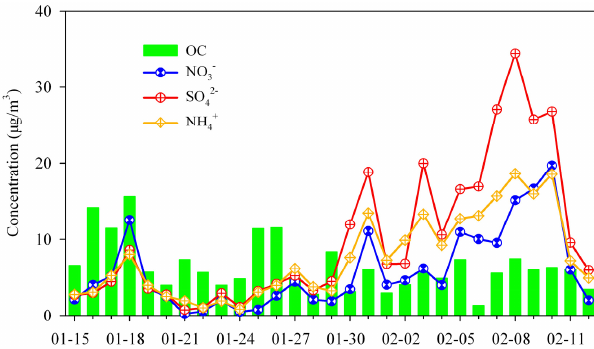
, SO 2 − , and NH + concentra- 3 4 4